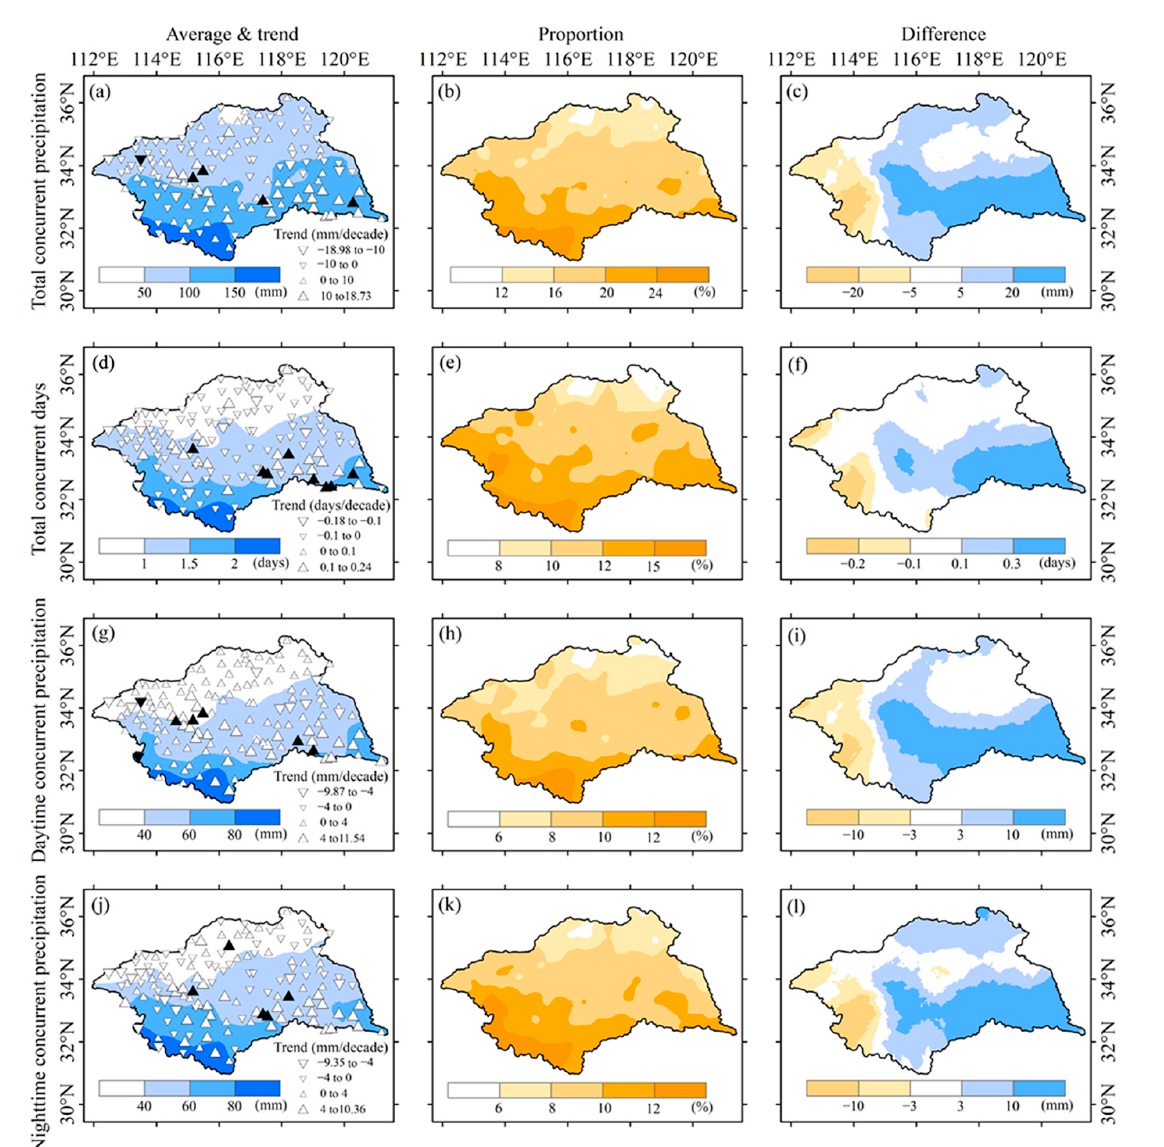
Figure 16. Spatial patterns of ( a ) mean CEDNP amount and trend (1961–2018), ( b ) the proportion of CEDNP amount to TR90p, and ( c ) the average difference of CEDNP amount between 1990–2018 and 1961–1989. ( d – f ) The same as ( a – c ), but for the CEDNP days. The spatial characteristics of ( g ) average daytime precipitation amount and trend under CEDNP, ( h ) the proportion of daytime precipitation amount to CEDNP under TR90p conditions, and ( i ) the average difference of daytime precipitation under CEDNP conditions between 1990–2018 and 1961–1989. ( j – l ) the same as (g– i ), but for nighttime precipitation to CEDNP. Upward and downward triangles denote increase and decrease trends, respectively; solid triangles represent linear trends at the p < 0.05 significance